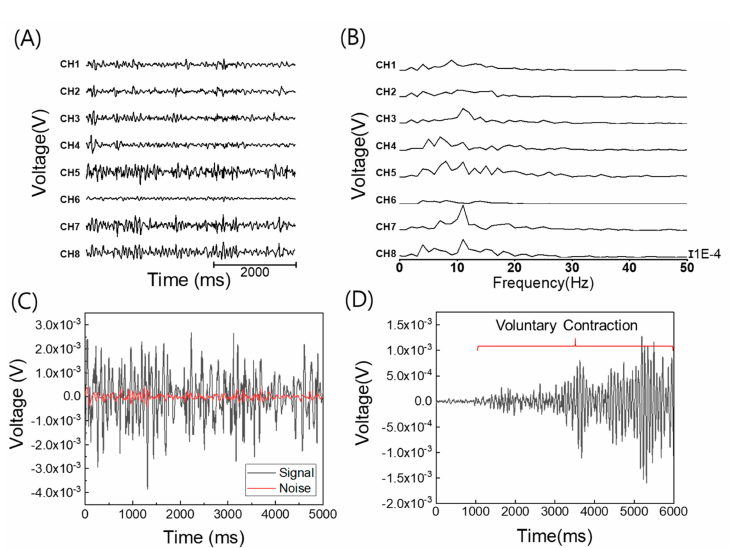
Figure 3. Recorded sEMG (surface electromyography) data from the 8-channel microelectrode array. ( A ) A set of sEMG signals in the time domain. ( B ) A set of FFT (fast Fourier transform) data in the frequency domain. ( C ) Signal to baseline noise ratio (SNR). ( D ) sEMG signal change depending on the increasing load for measuring the maximum voluntary contraction